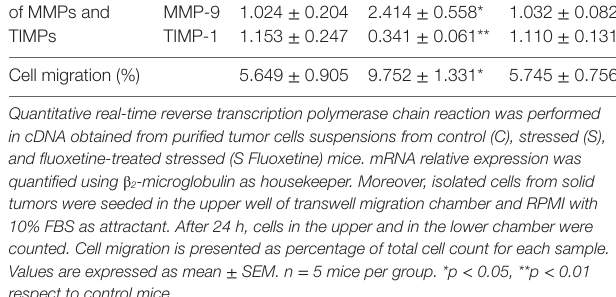
TaBle 2 | Effect of chronic stress and fluoxetine treatment on molecular changes and migratory ability in immune cell-depleted tumor cells.